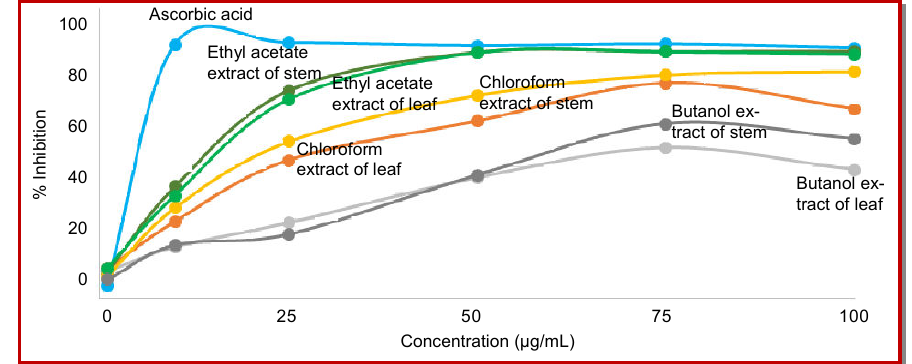
Figure 1: DPPH scavenging activity of different extracts of Genista ferox and ascorbic acid as a standard